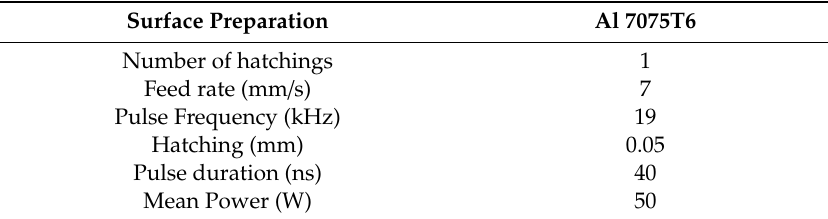
Table 3. Surface homogenization parameters for Al 7075T6.